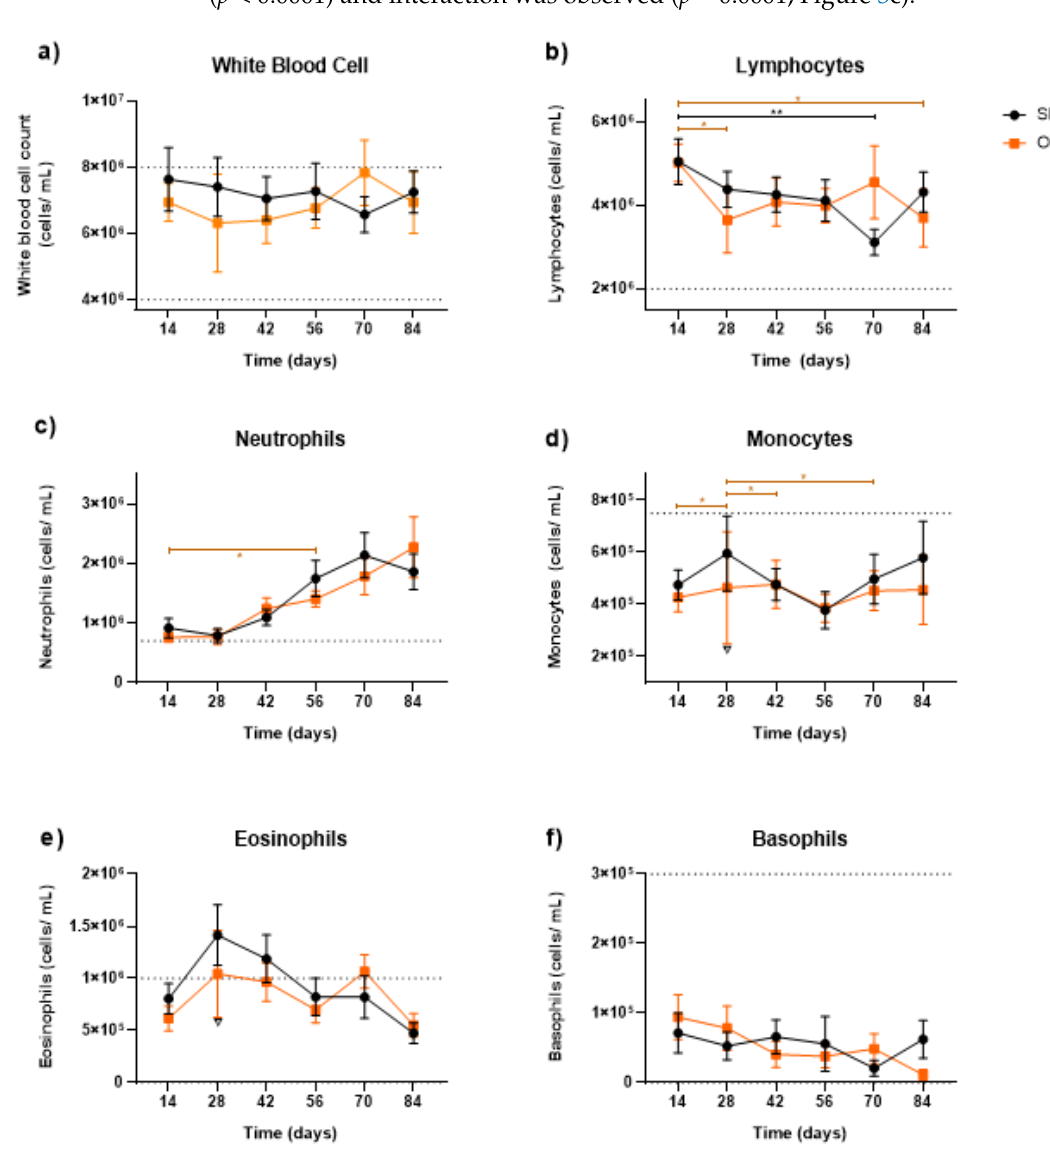
Figure 3. Mobilization of ( a ) total leukocytes; ( b ) lymphocytes; ( c ) neutrophils; ( d ) monocytes; ( e ) eosinophils; and ( f ) basophils (cells/mL of blood) during exposure to heat stress over the summer. * represents statistical variation over time ( p < 0.005) of the OP system. ** represents statistical variation over time ( p < 0.005) of the SP system. All values are represented as Mean ± SD.